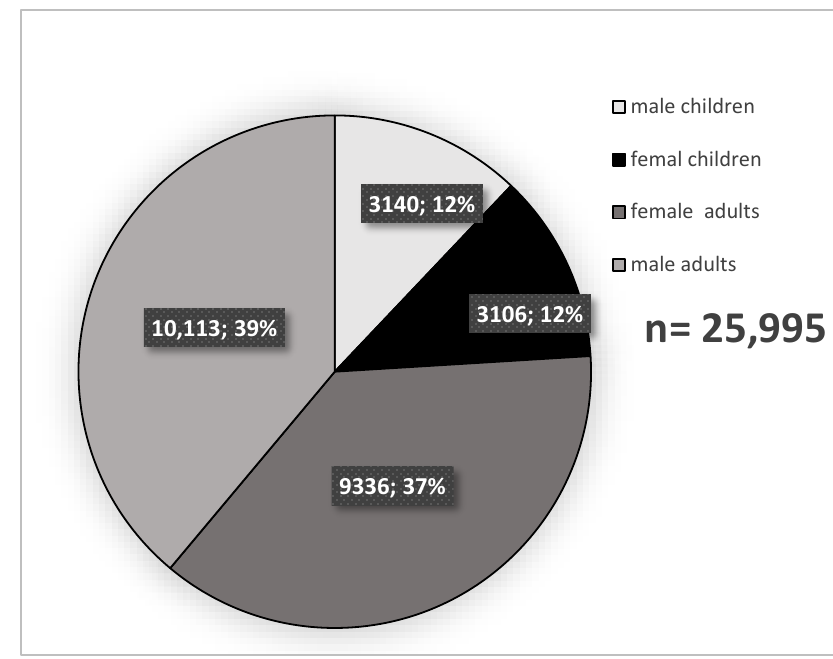
Figure 1. Number of all patients with acute appendicitis, 2010–2017 ( n =